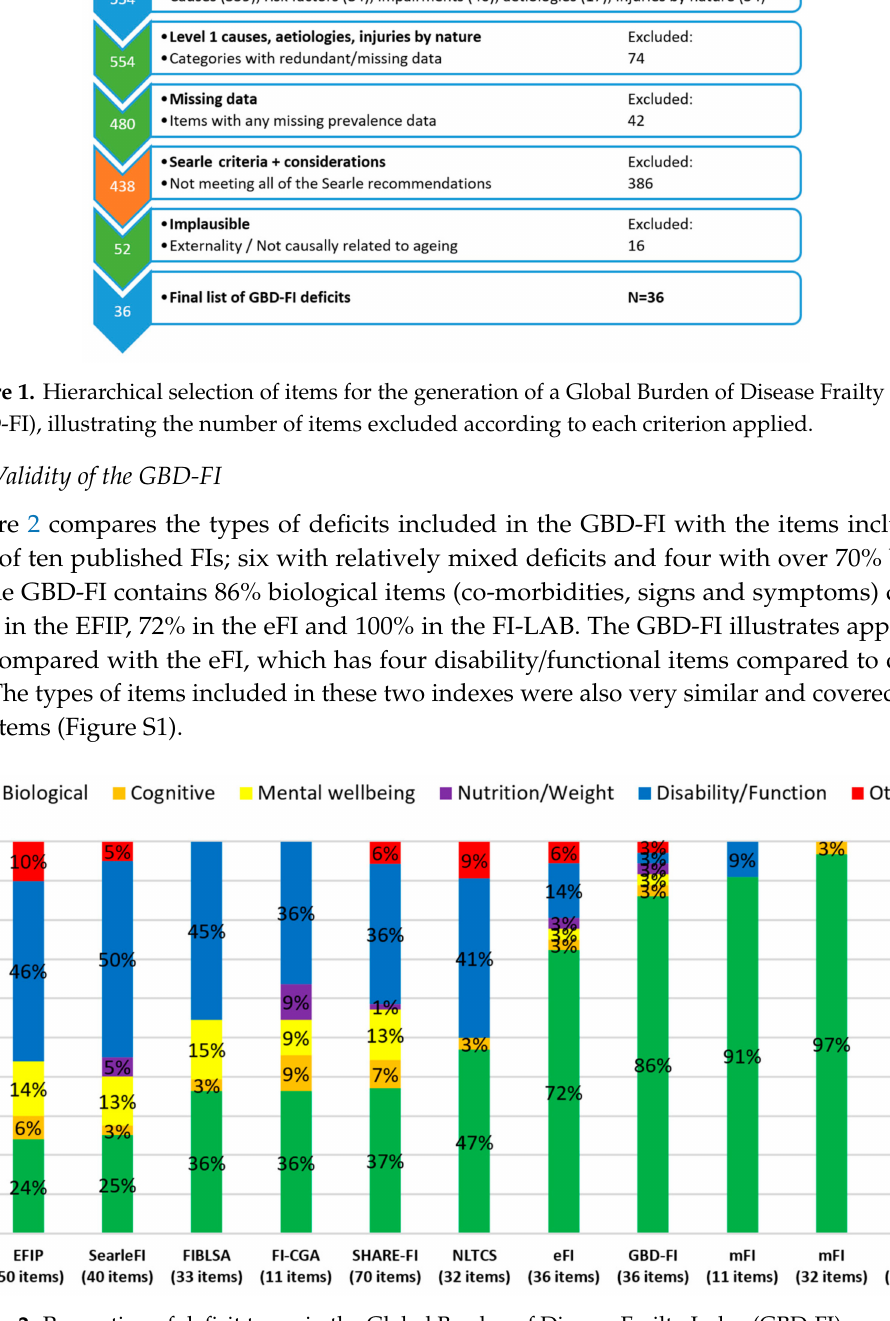
Figure 2. Proportion of deficit types in the Global Burden of Disease Frailty Index (GBD-FI) compared with a range of published Frailty Indexes (FIs). Frailty Index for Physical Activity (EFIP) [32]; Frailty index from Searle et al. [11]; a frailty index from the Beijing Longitudinal Study of Aging (FIBLSA) [33]; the Comprehensive Geriatric Assessment frailty index (FI-CGA) [21]; a 70-item Frailty Index (SHARE-FI) [34] the National Long Term Care Survey Frailty Index (NLTCS) [35]; and the Electronic frailty index (eFI) [17], the 11-item modified Frailty index (mFI) [36], the 32-item multimorbidity frailty index (mFI) [37] and the first laboratory frailty index (FI-LAB) [38]. ‘Other’ refers to self-rated health, hospitalisation, falls and injuries in these